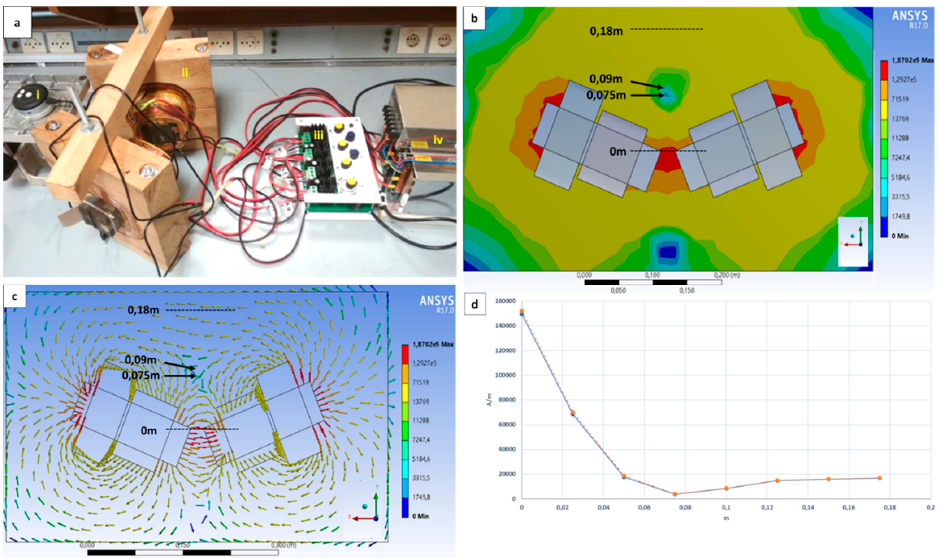
Figure 2. The whole apparatus is depicted in ( a ): (i) the microscope used to monitor the movement of the magnetic droplet; (ii) electromagnets; (iii) the control system; (iv) the power supplies. ( b , c ) Simulations for the magnetic field intensity propagated by the electromagnets are shown, as well as the vectors of the field. Arrows in ( b,c) indicate the cancellation area created at given distance from magnet cores and the initial position of the magnetic sphere and microdroplet. ( d ) The magnetic field intensity measured by a Hall sensor (orange color) in comparison with the results of the simulation from ANSYS (blue color). The measurements are taken on the centerline starting from the last point of the cores (dashed lines). The scale bars are in meters.